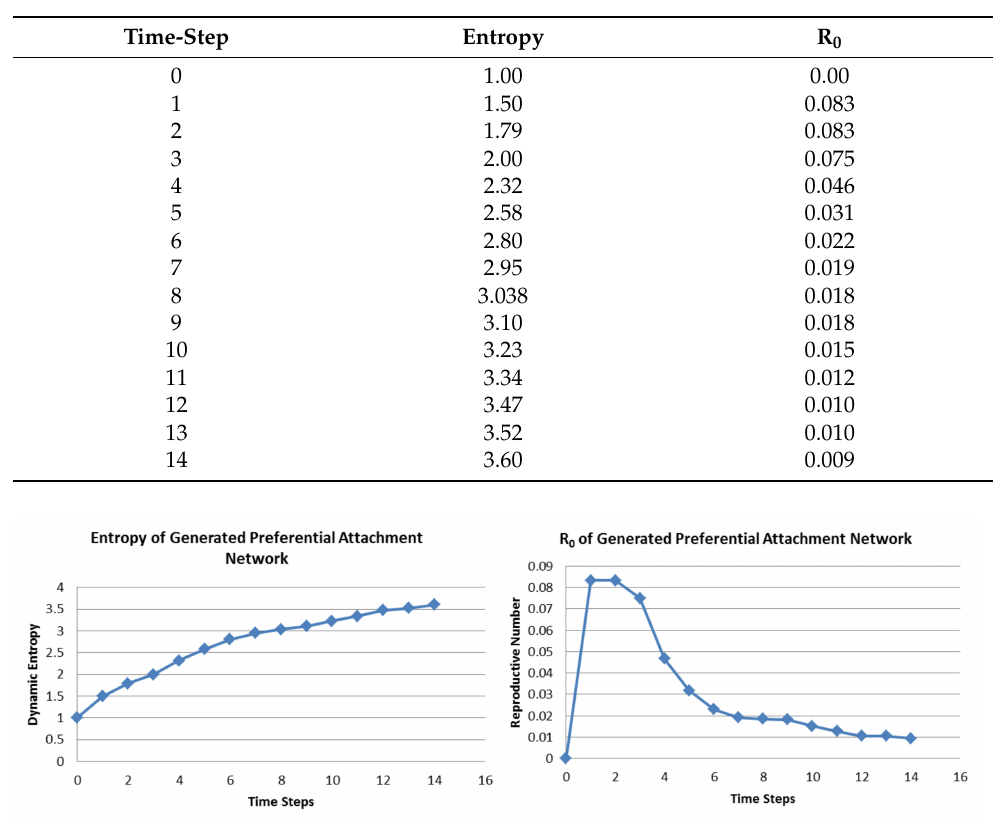
Table 4. Temporal evolution of entropy and R 0 values for the generated preferential attachment network model.